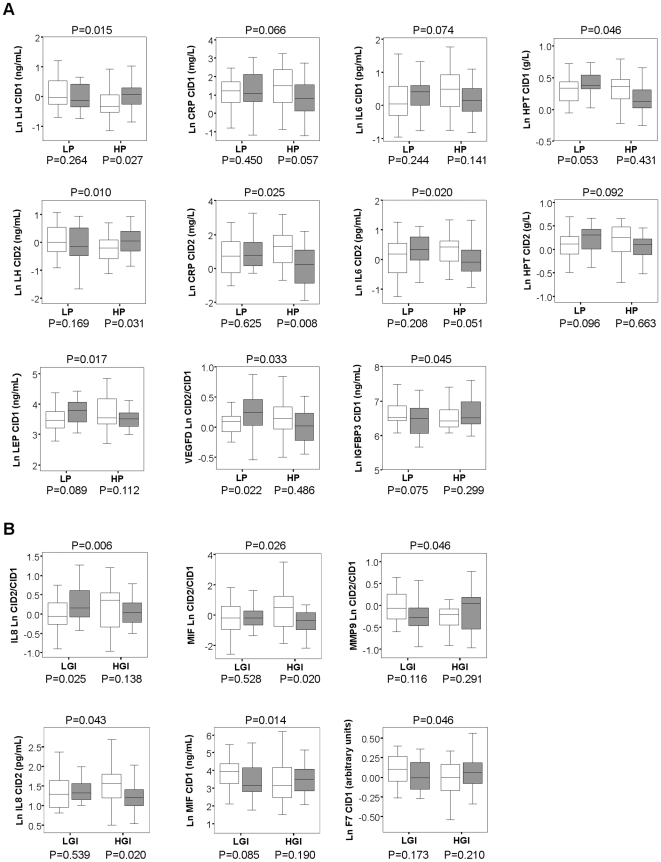
Predictors having interaction with dietary components for the outcome of weight maintenance.Boxplots show the quartile range of the blood analytes without outliers for continued weight-losers (blank bar) and weight-regainers (grey bar) in each dietary group. The p-value above the chart is the significance of the interaction between dietary protein/GI and the concentration/change of the blood analyte with respect to the outcome of weight maintenance (weight-loss or -regain). The p-values under the chart is the significance of the prediction of the variable inside the subgroups. All were obtained by logistic regression (controlled for age and the fold change of weight). A. predictors having interaction with dietary protein levels. LP: low protein, HP: high protein. B. predictors having interaction with dietary glycemic index (GI) levels. LGI: low GI, HGI: high GI.